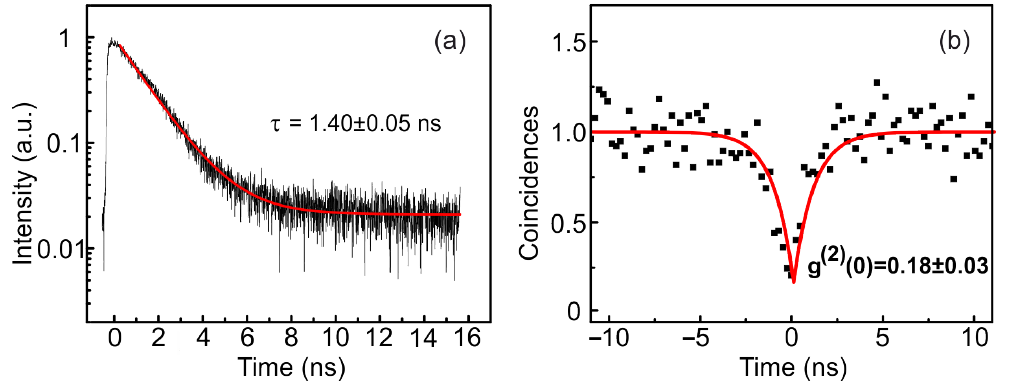
Figure 3. ( a ) Characteristic decay curve of the radiation from the QD in the photonic nanoantenna with the characteristic decay time of 1.4 ns. ( b ) Normalized second-order correlation function g ( 2 ) of single-photon emission, measured at 8 K for a spectrally filtered single excitonic line. The obtained value of g ( 2 ) (0) is 0.18. The autocorrelation function and decay curve were measured at the most intensive excitonic peak in Figure